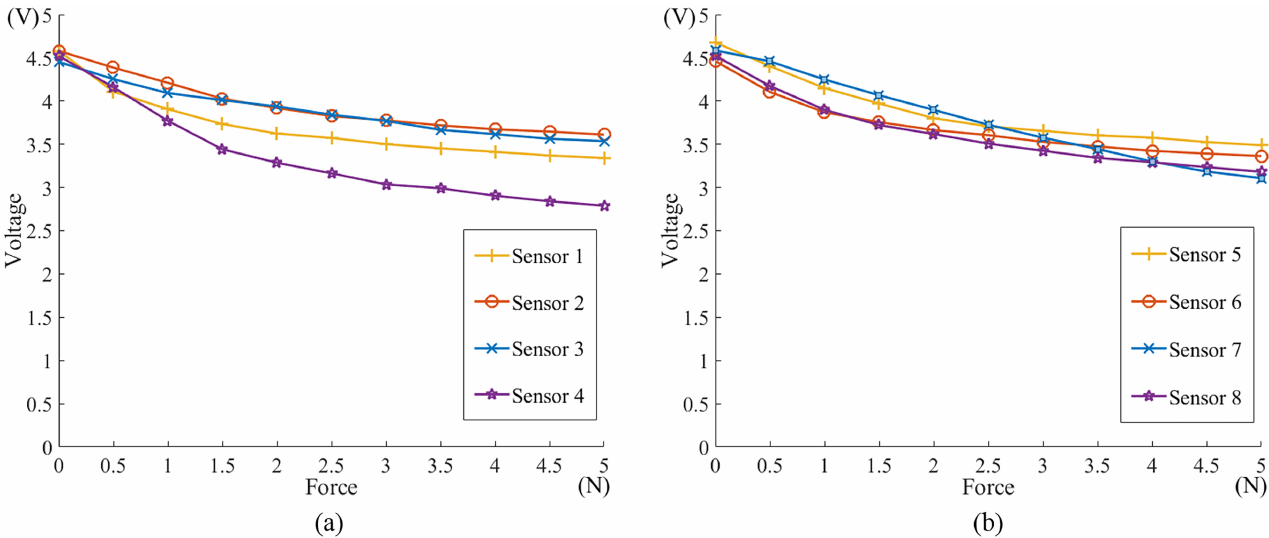
Figure 5. Measured voltage-force curves of each force sensitive element. ( a ): Voltage-force curves of Sensor 1 to 4. ( b ): Voltage-force curves of Sensor 5 to